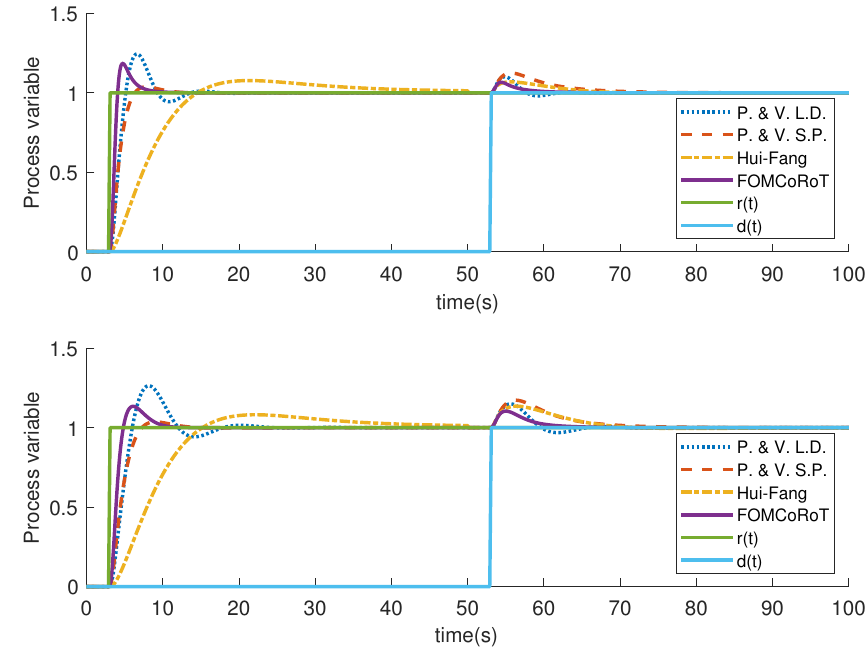
= 2.0 (at the top ) and for M t S